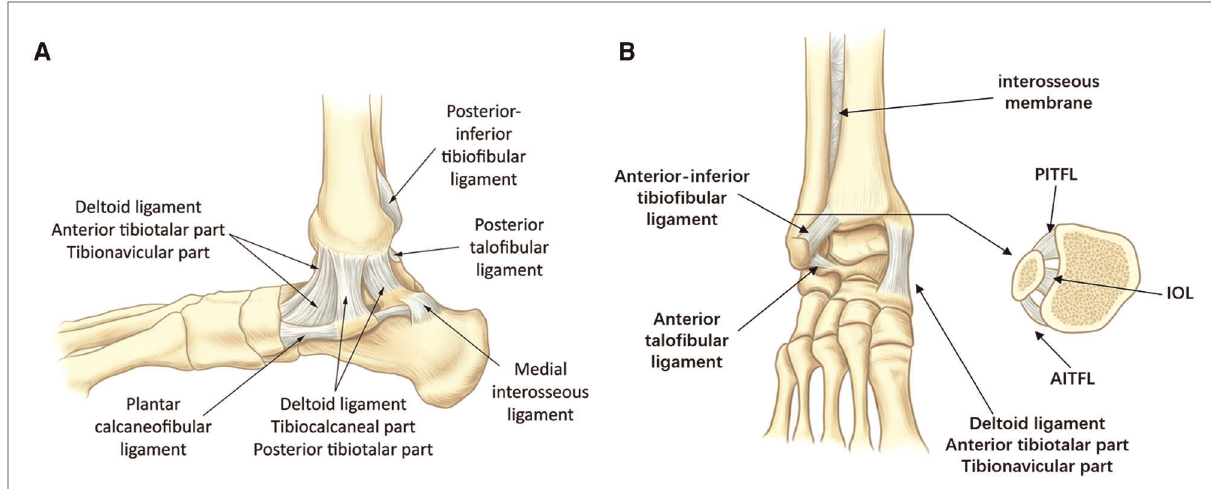
FIGURE 2 The periprosthetic ligament of the ankle joint complex. ( A ) Medial view. ( B ) Anterior view. Note: AITFL, anterior tibio fi bular ligament; IOL, interosseous ligament; PITFL, Posterior tibio fi bular